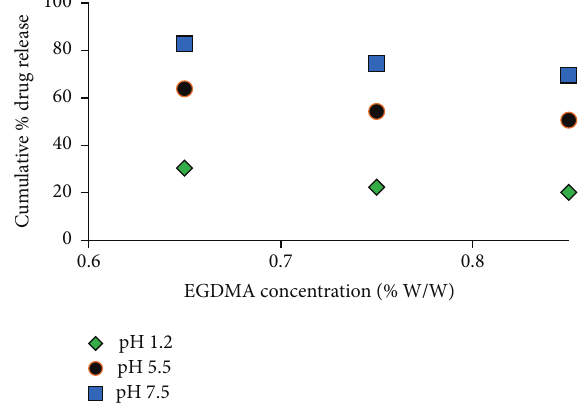
Figure 8: Cumulative % release of pheniramine maleate from AA/Gelatin hydrogels after 12h using different concentrations of EGDMA ascross-linkingagent (0.65%, 0.75%, and 0.85%) at various pH values in 0.05 M USP phosphate buffer